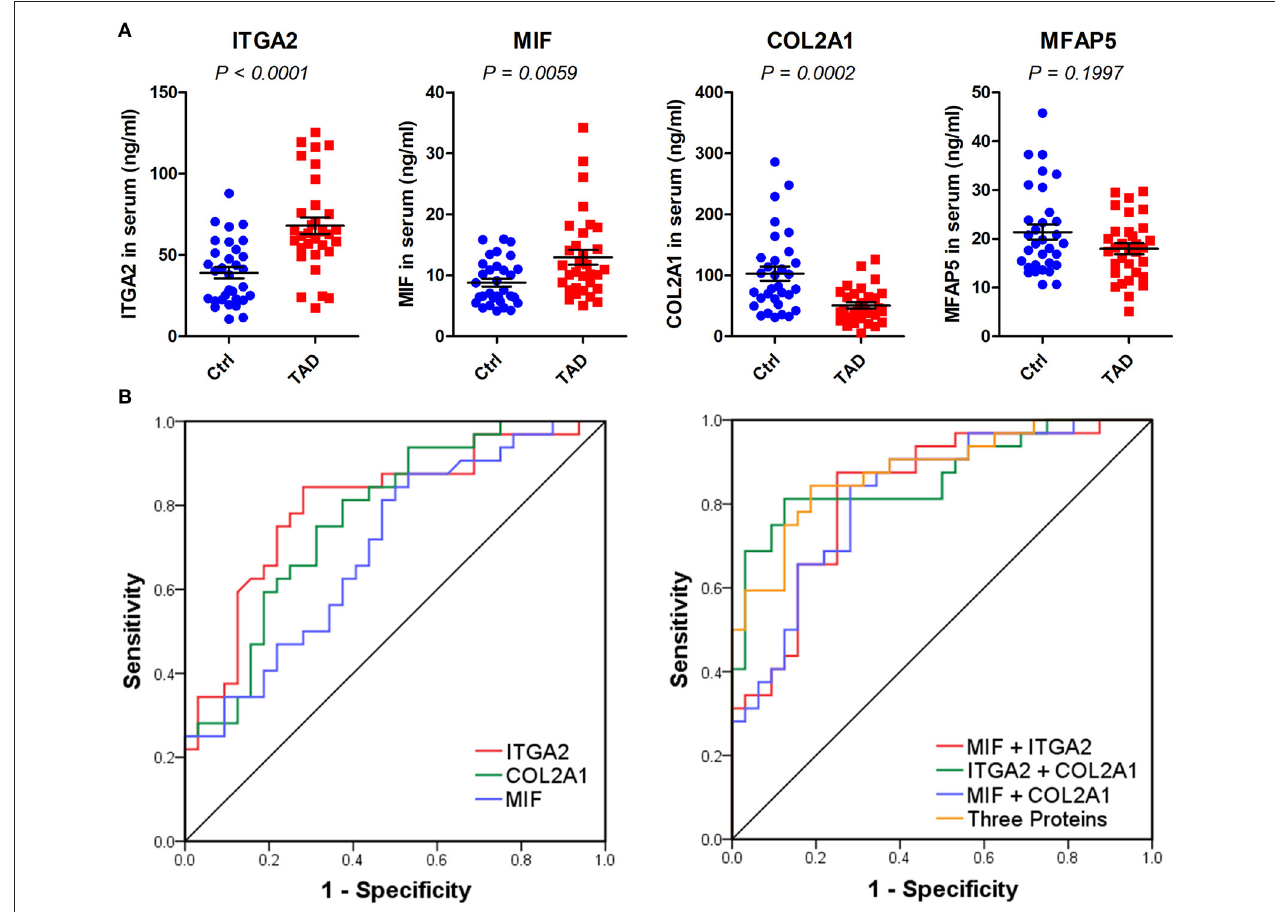
FIGURE 6 | Validation of MIF, ITGA2, COL2A1, and MFAP5 in serum samples via ELISAs. (A) Relative expression of the four indicated proteins in the validation phase, n = 64. P -values were determined by the Mann-Whitney test. (B) ROC curves of MIF, ITGA2, COL2A1, and the combination of the three proteins in the validation phase. The predicted values of the combination of each protein were calculated by binary logistic